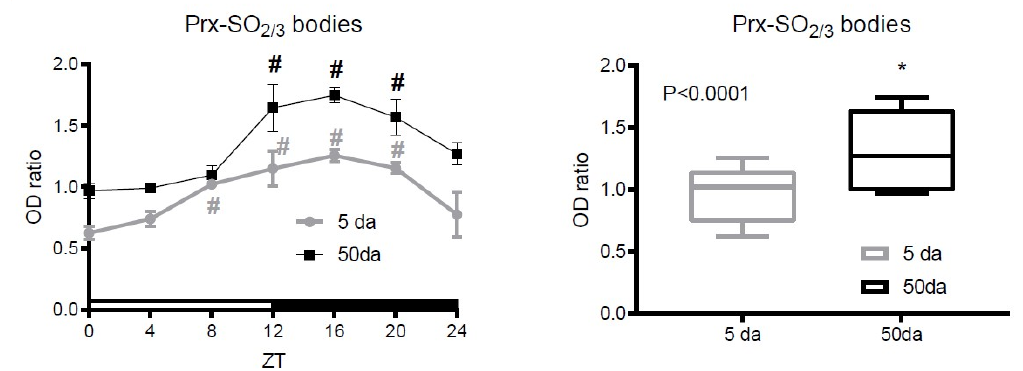
Figure 3. Analysis of daily changes in peroxiredoxin hyperoxidation in young (5 da) and old (50 da) flies. Canton flies were raised under LD conditions and collected for analysis at 4 h intervals. Samples were prepared from bodies of male flies. Immunoblots were performed under reducing conditions and developed with an antibody that recognizes Prx-SO2/3 forms and re-probed with specific Prx antibodies. In addition, Ponseau staining was used to standardize for loading. Signals obtained with anti-Prx-SO2/3 antibodies were normalized to signals obtained with Ponseau staining and ratios are plotted on the Y axis. Zeitgeber time (ZT), where ZT0 is time of lights “on” and ZT12 is time of lights “off”, is plotted on the X axis. Data represent average values ± SEM obtained from three independent bio-replicates. Significance was analyzed by 2-way ANOVA with Bonferonni post-test. Each replicate was normalized to the material collected from 5 da flies at ZT0 time point. Statistically significant differences are marked by asterisks. In the graphs shown on the left, # marks statistically significant differences between ZT0 and ZT4-24. In the graphs shown on the right, * marks a significant difference between 5 da and 50 da flies. Representative immunoblot images are shown in Figure S2B.